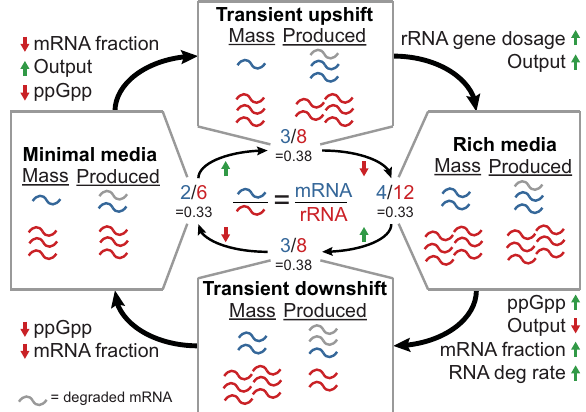
Fig. 6 Transient increases in the mRNA to rRNA ratio arise through different mechanisms during nutrient up- or downshifts. Schematic demonstrating a toy example of how an increase or decrease in ppGpp concentration can lead to similar increases in the mRNA to rRNA ratio. “ Mass'' represents the amount of RNA (blue: mRNA, red: rRNA, gray: degraded mRNA) that would already be present at the start of a cell cycle and “ Produced'' represents the number that will be produced throughout a cell cycle. Note that in minimal or rich media there is balanced growth with mRNA and rRNA both doubling; however, during transient shifts, these amounts need not be balanced. Text in the outer corners describes signi fi cant changes when shifting from one box to another based on simulation observations. In the center, the mRNA to rRNA ratio is shown for each condition with the transient shift conditions both showing higher ratios than the steady state minimal or rich